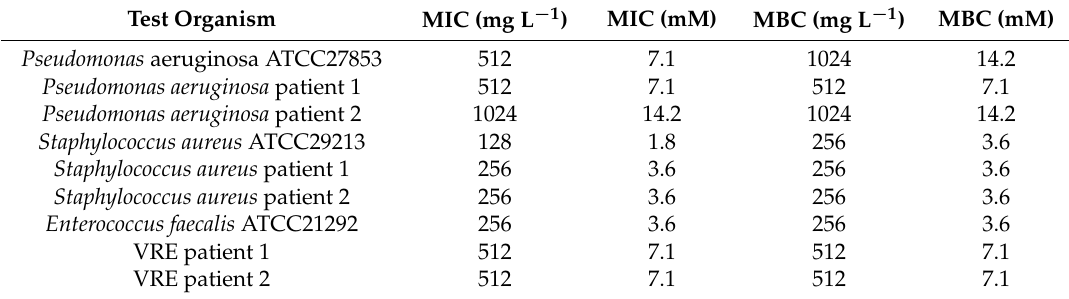
Table 6. Minimum inhibitory concentration (MIC) and minimum bactericidal concentration (MBC) (mg L − 1 ) of MGO in liquid form against three common wound pathogens. VRE: vancomycin-resistant Enterococcus faecalis